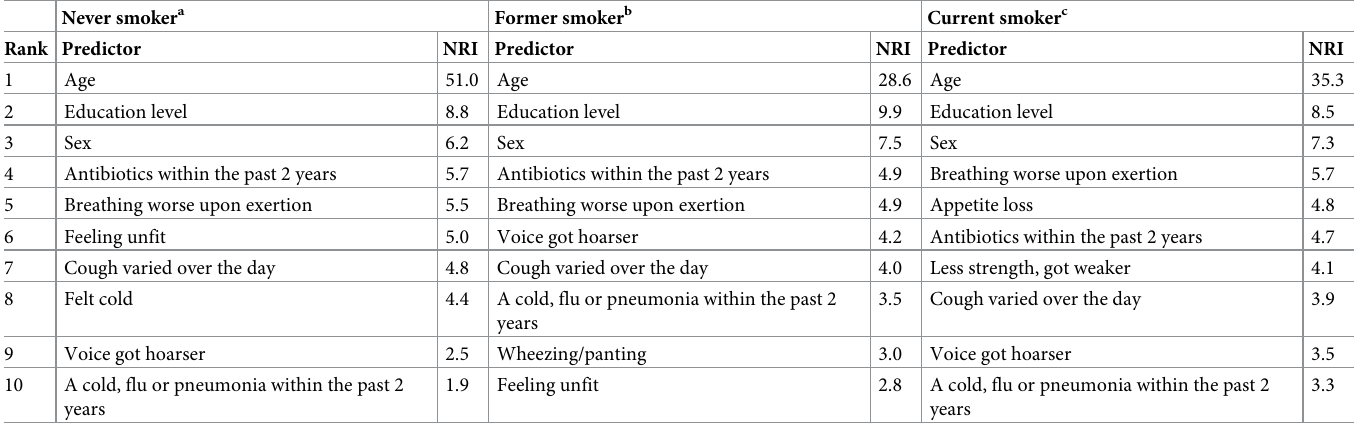
Table 4. Predictors with highest normalized relative influence (NRI) for the stochastic gradient boosting models according to smoking status. Never smoker